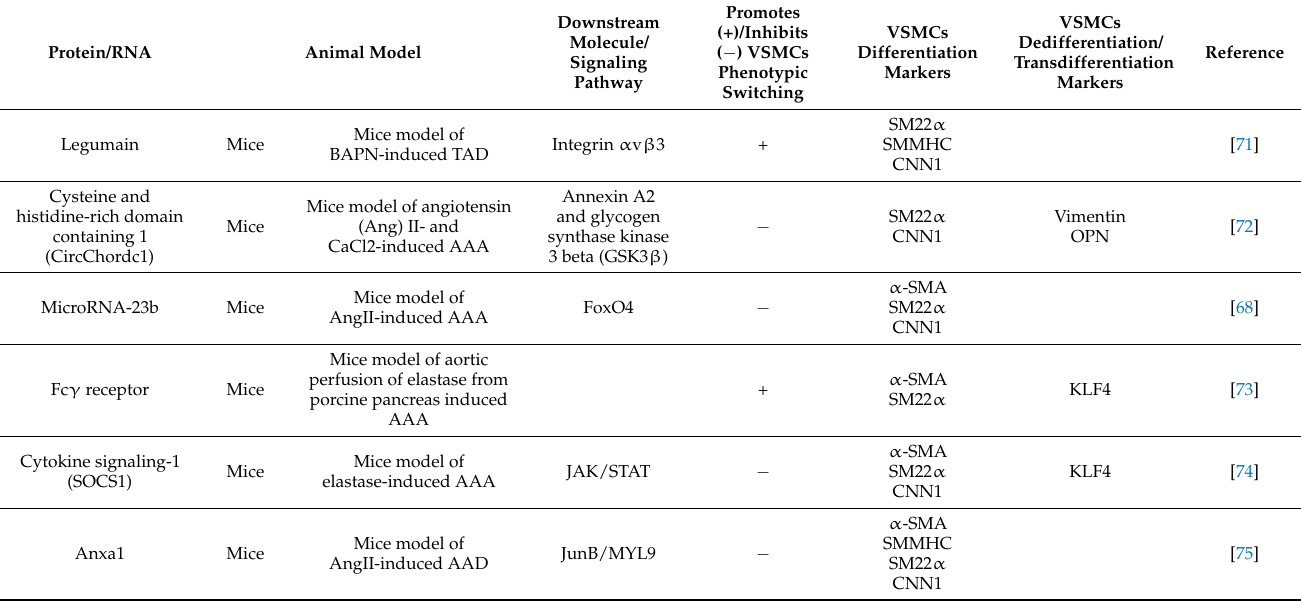
Table 3. Molecular mechanisms of VSMCs phenotypic switching in Aortic